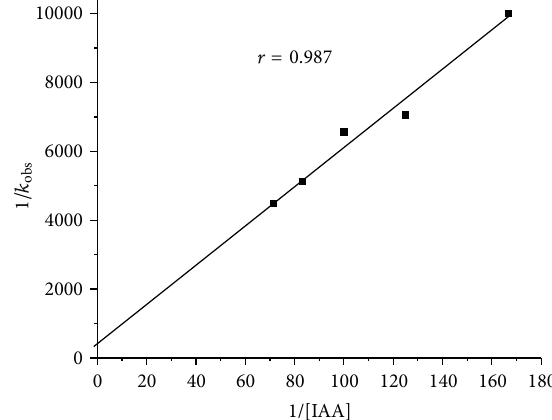
F 1: Plot of versus log[IAA] for TPP catalysed obs oxidation of IAA by peroxomonosulphate in acetonitrile medium. log𝑘𝑘